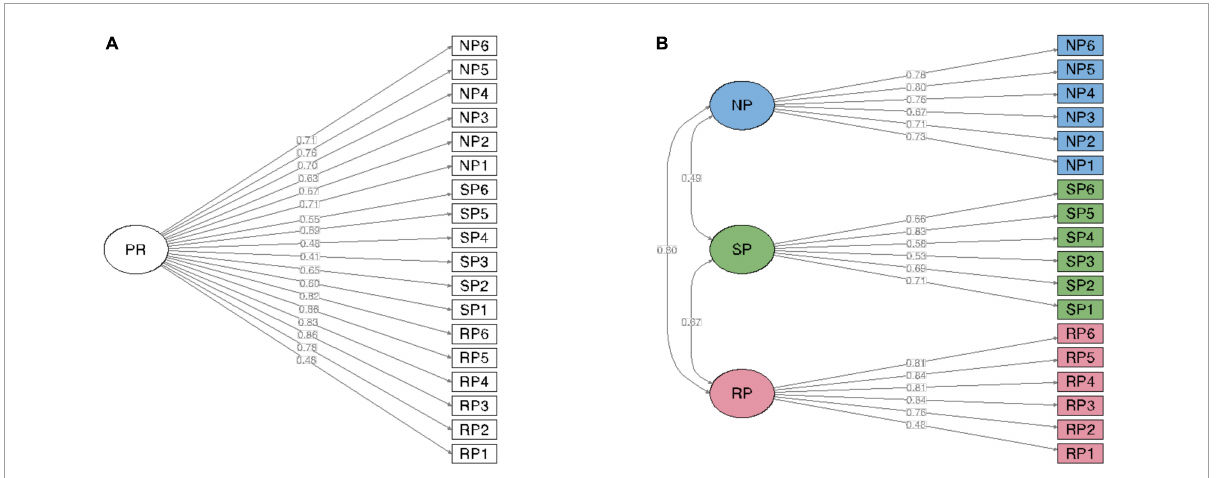
FIGURE1 The Big Three Perfectionism Scale–Short Form: Confirmatory factor analysis with weighted least squares means and variance adjusted (WLSMV) estimation. (A) One-factor model. (B) Three-factor model ( n = 401). PR, Perfectionism; SP, Self-critical perfectionism; NP, Narcissistic perfectionism.